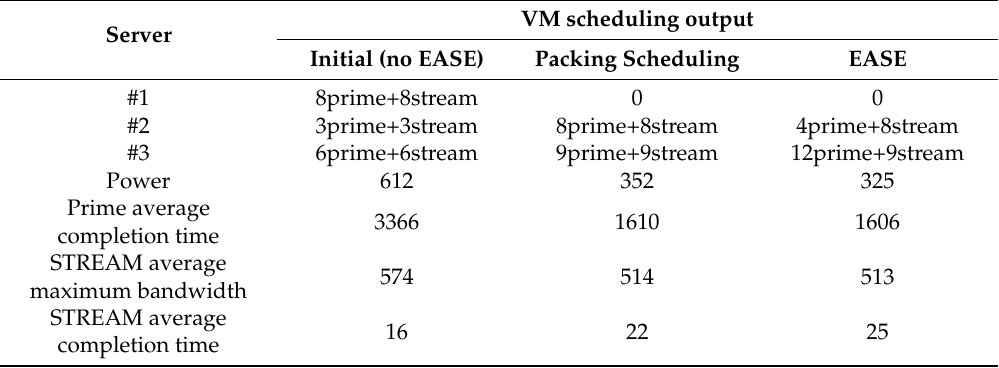
Table 11. Power consumption and performance comparison of a heterogeneous cluster before and after scheduling (mixed